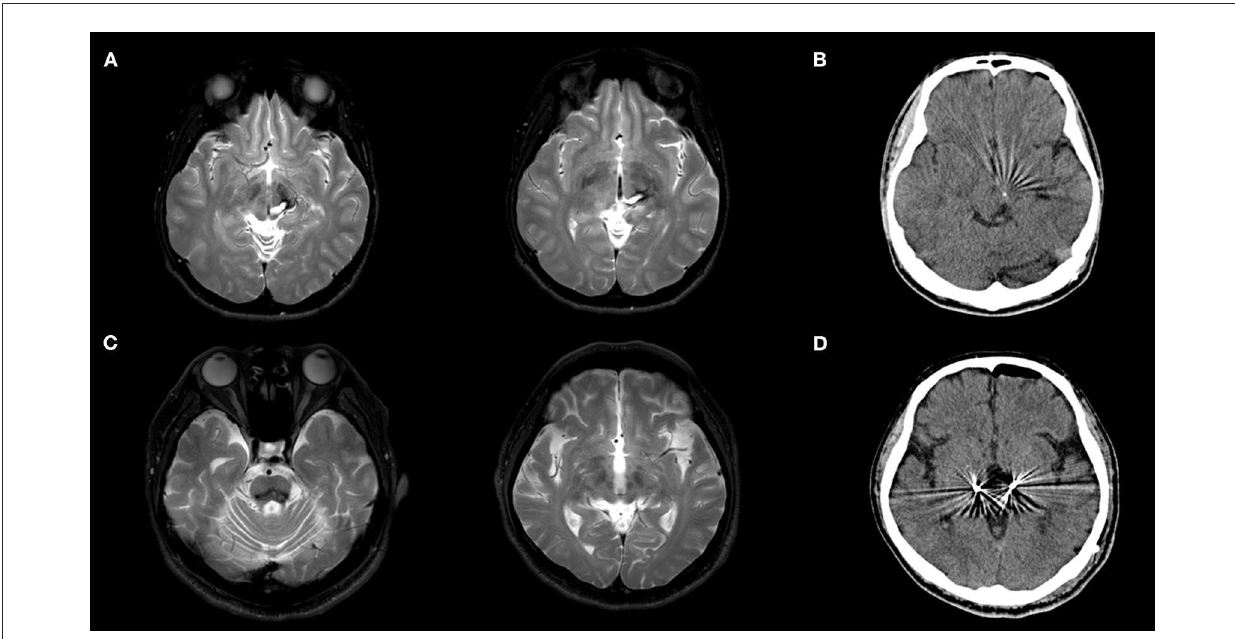
FIGURE1 (A) Brain MRI showed an old hemorrhage in patient 1. (B) Postoperative CT showed the electrode was precisely implanted in the PSA in patient 1. (C) Brain MRI showed the old hemorrhage in the pons in patient 2. (D) Postoperative CT showed the electrodes were precisely implanted in the PSA in patient